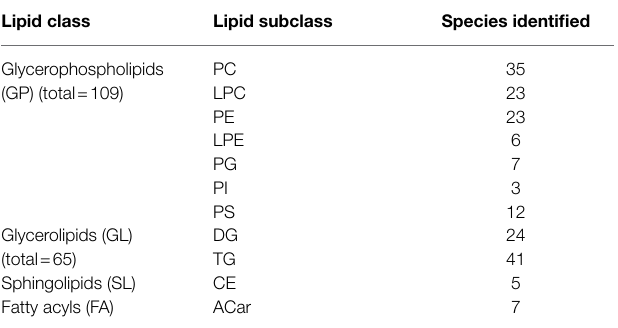
TABLE 3 | Number of detected lipid species in roots of two barley genotypes (cv. Vlamingh and cv. Gairdner) from four treatment groups: control C, control inoculated with fungus CF , salt (200 mM NaCl) S, and salt inoculated with fungus SF. An LC-TripleTOF-MS was used for the analysis (positive ionisation mode).